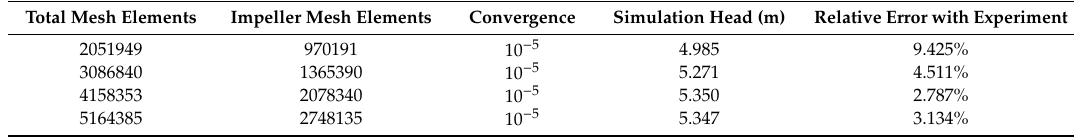
Table 2. Verification of grid independence.